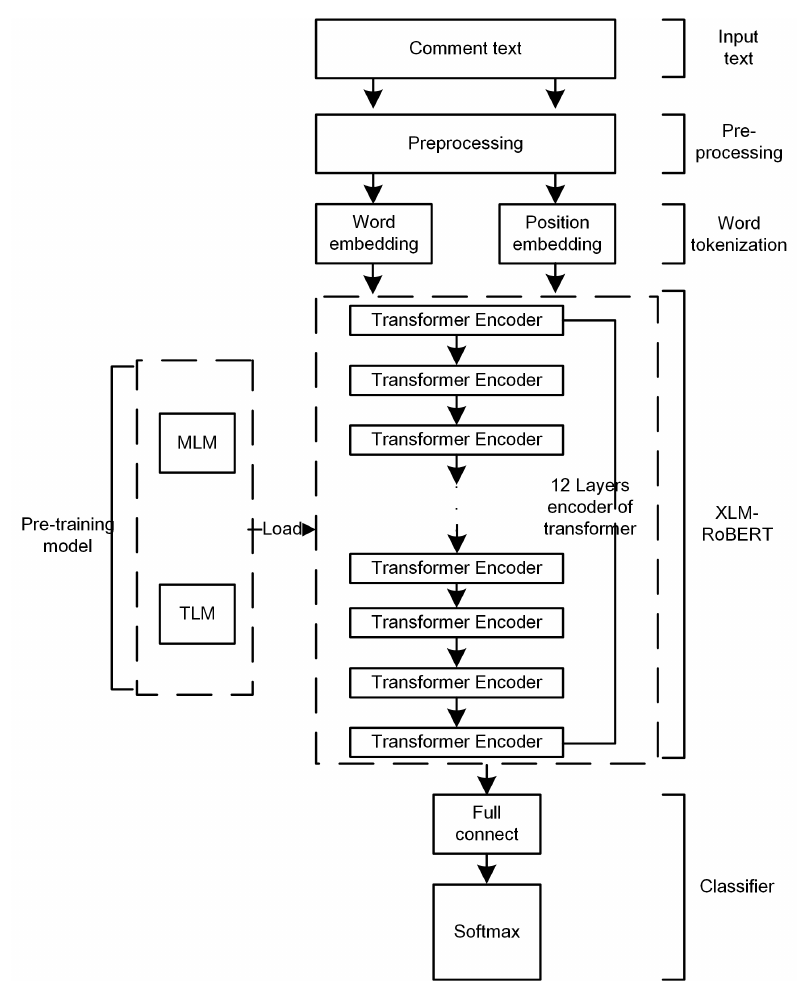
Figure 1. The Proposed Neural Architecture for Multilingual Toxic Text